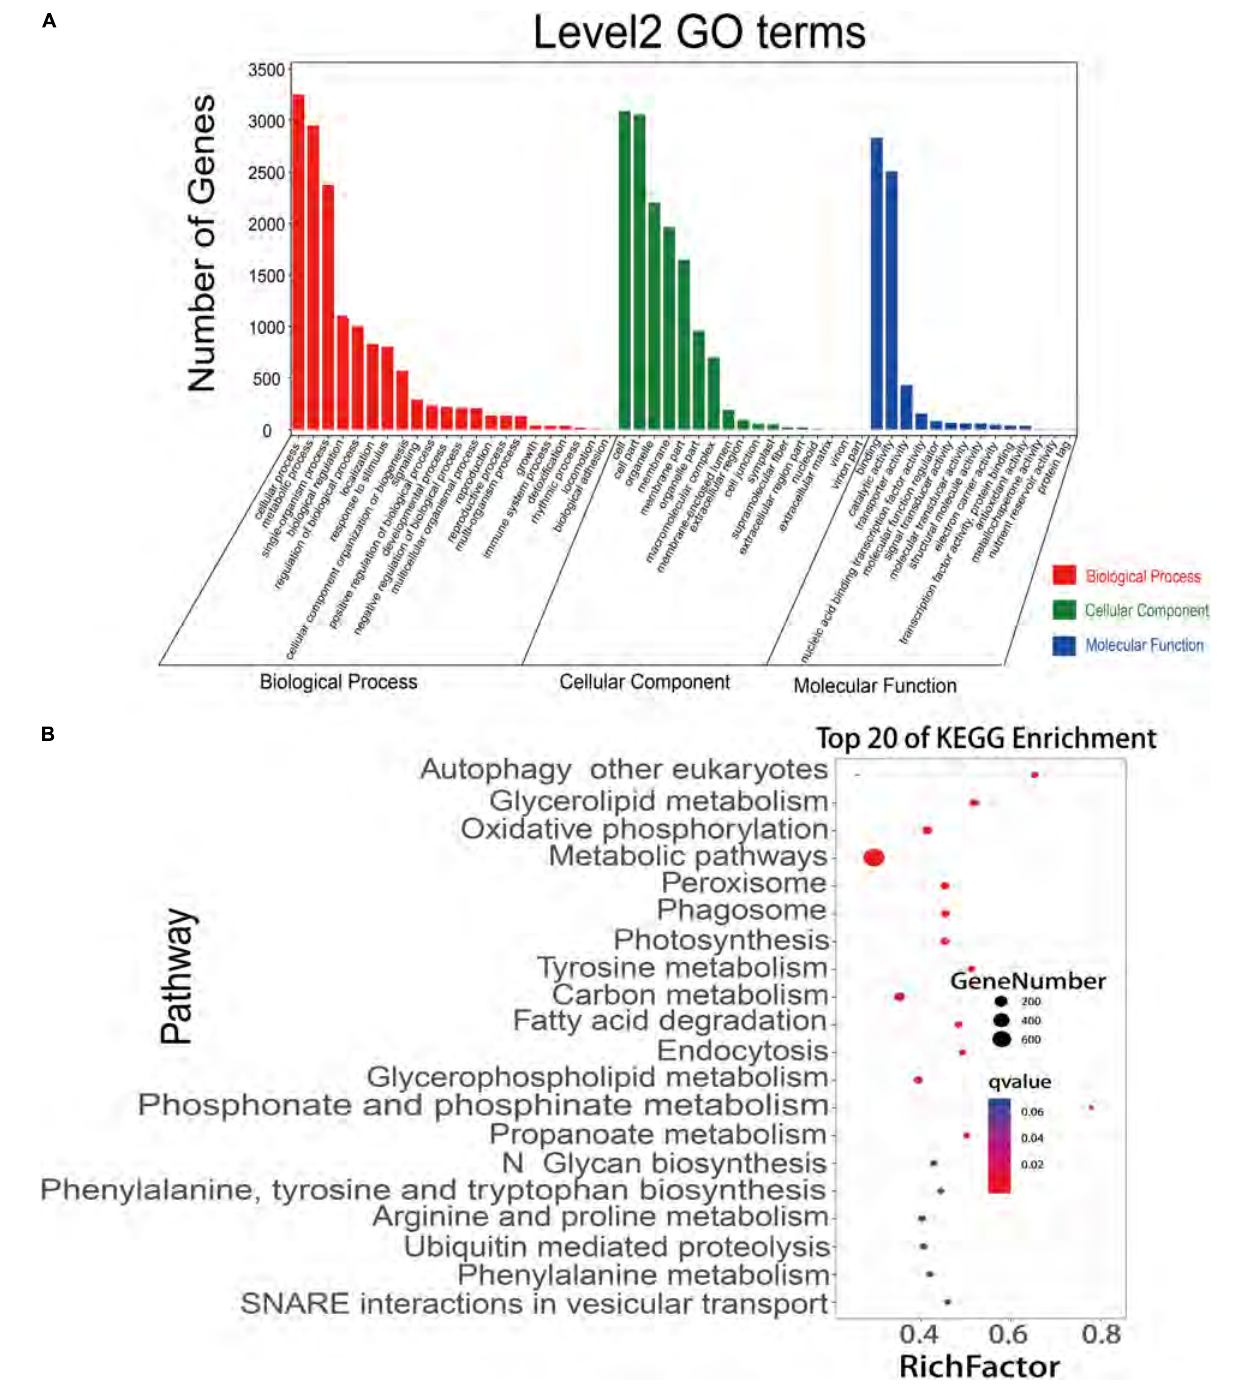
FIGURE 7 | GO annotations and KEGG pathway analyses of differentially expressed mRNAs. (A) mRNAs were significantly enriched in GO terms ( P -value < 0.05). (B) KEGG pathways involving the top 20 terms. Q -value ranges from 0 to 1. The closer to zero the Q -value is, the more significant the enrichment is. A larger RichFactor value indicates a higher degree of